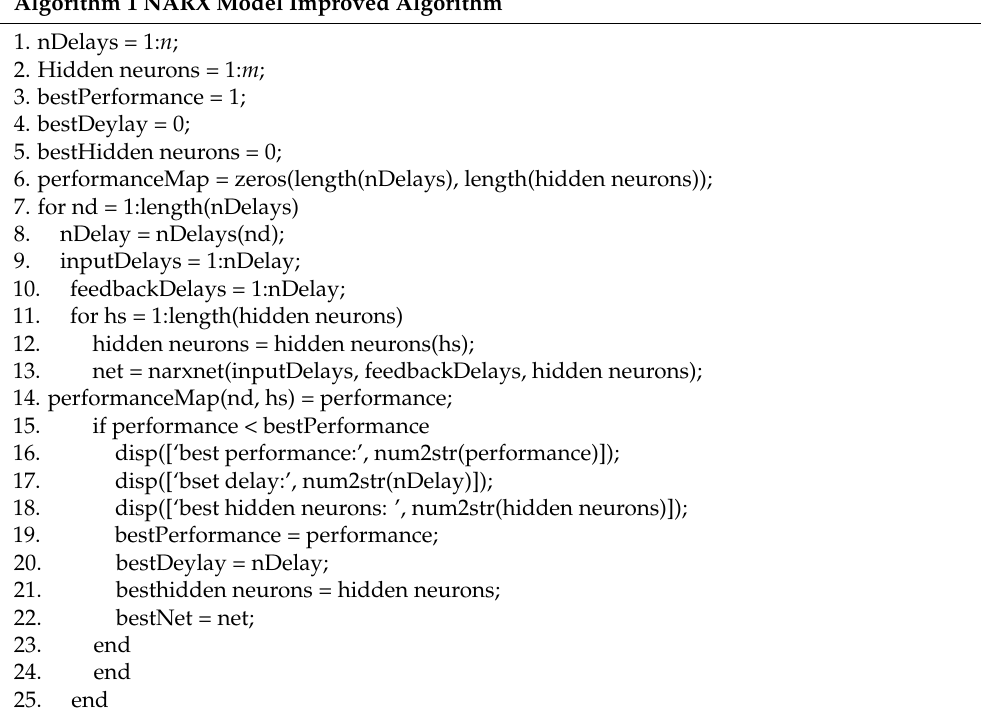
Table 1. Improved algorithm of the NARX model. Algorithm 1 NARX Model Improved Algorithm